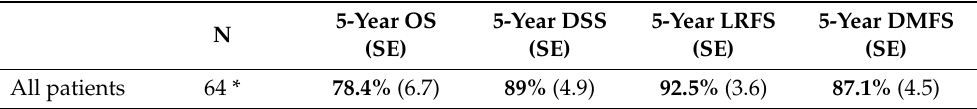
Table 4. Survival